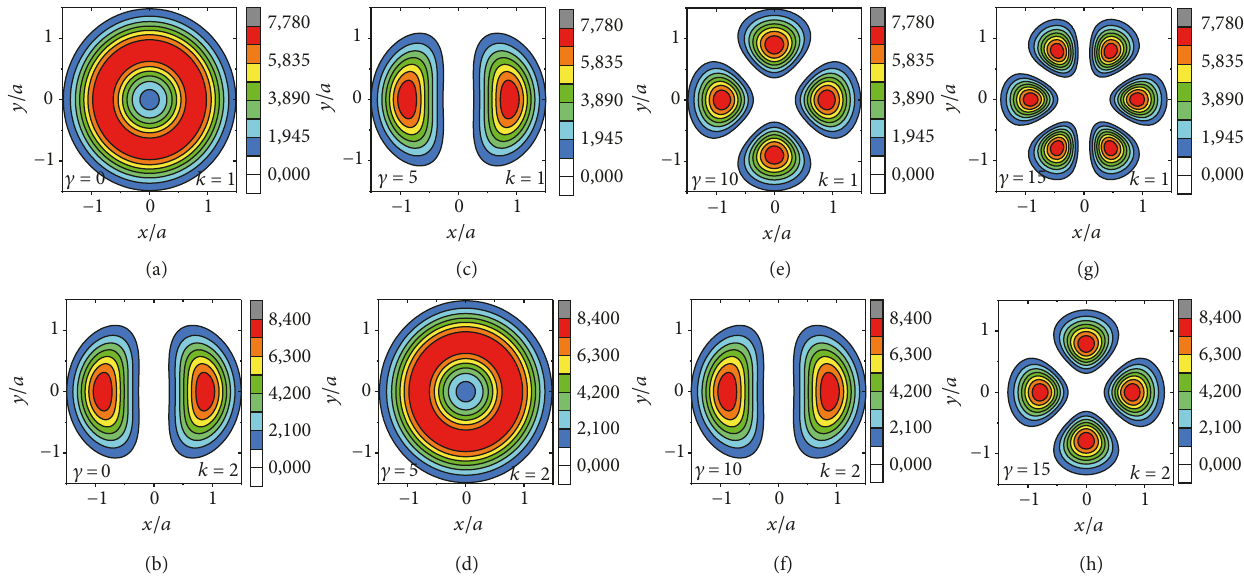
Figure 4: Charge distribution for on-center donor in the ground state (a, c, e, g) and in the first excited state (b, d, f, h) for 𝛾 = 0, 5,10, 15 in circular QR.